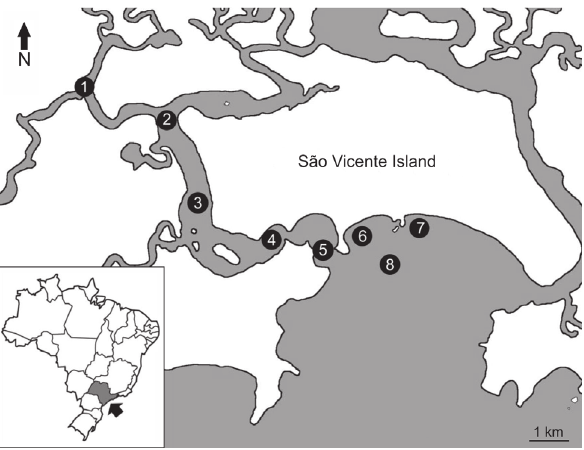
Figure 1. Estuary-Bay Complex of São Vicente, showing the sam- pling locations in the estuary (transects 1, 2, 3 and 4) and in the bay (transects 5, 6, 7 and 8). Conic projection, WGS84. Source: Timoteo T. Watanabe.